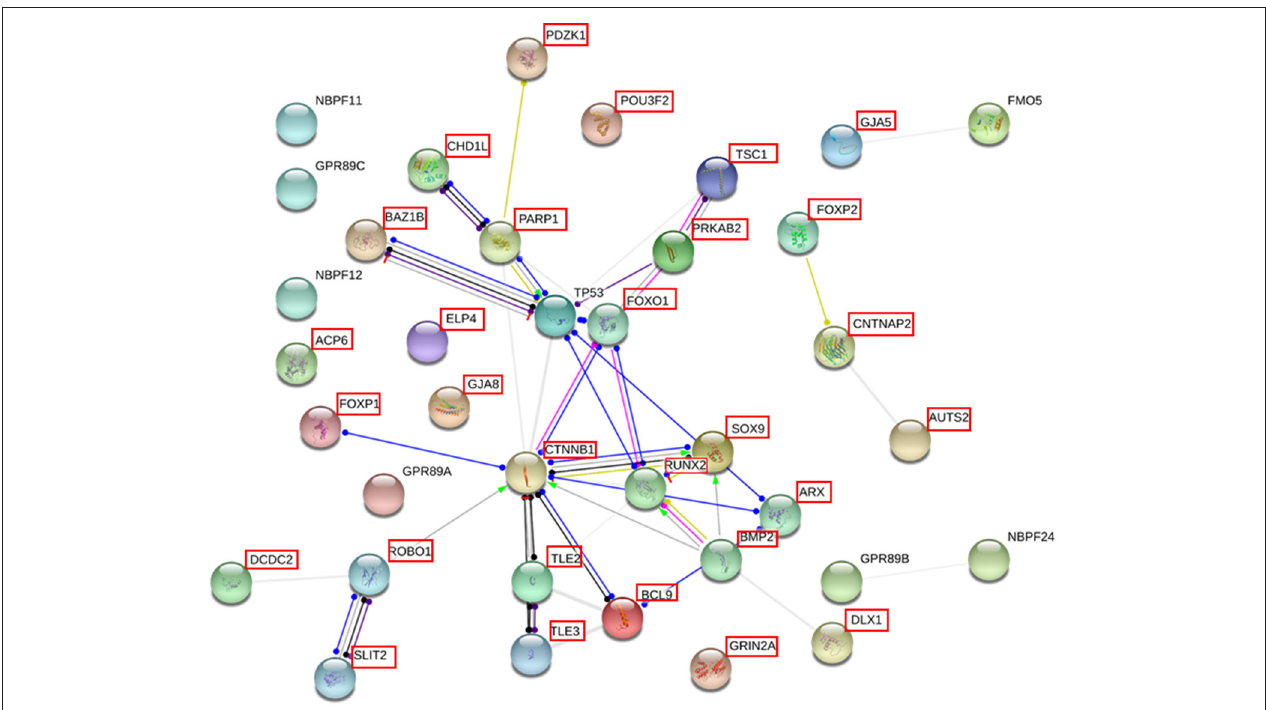
FIGURE 5 | Interaction network of the proteins coded for the most relevant genes duplicated in the proband. The network was drawn with String [version 10.5; (39)] license-free software (http://string-db.org/), using the molecular action visualization. It includes the products of the protein-coding genes duplicated in the subject, their potential interactors according to String, and the products of 15 strong candidates for language development/evolution. The proteins for which the expression level of the gene was measured in the blood of the patient by qRT-PCR are framed in red (the product of the pseudogene HYDIN2 is not included in the network). Colored nodes symbolize gene/proteins included in the query (small nodes are for proteins with unknown 3D structure, while large nodes are for those with known structures). The color of the edges represent different kind of known protein-protein associations. Green: activation, red: inhibition, dark blue: binding, light blue: phenotype, dark purple: catalysis, light purple: post-translational modification, black: reaction, yellow: transcriptional regulation. Edges ending in an arrow symbolize positive effects, edges ending in a bar symbolize negative effects, whereas edges ending in a circle symbolize unspecified effects. Gray edges symbolize predicted links based on literature search (co-mentioned in PubMed abstracts). Stronger associations between proteins are represented by thicker lines. The medium confidence value was 0.0400 (a 40% probability that a predicted link exists between two enzymes in the same metabolic map in the KEGG database: http://www. genome.jp/kegg/pathway.html). The diagram only represents the potential connectivity between the involved proteins, which has to be mapped onto particular biochemical networks, signaling pathways, cellular properties, aspects of neuronal function, or cell-types of